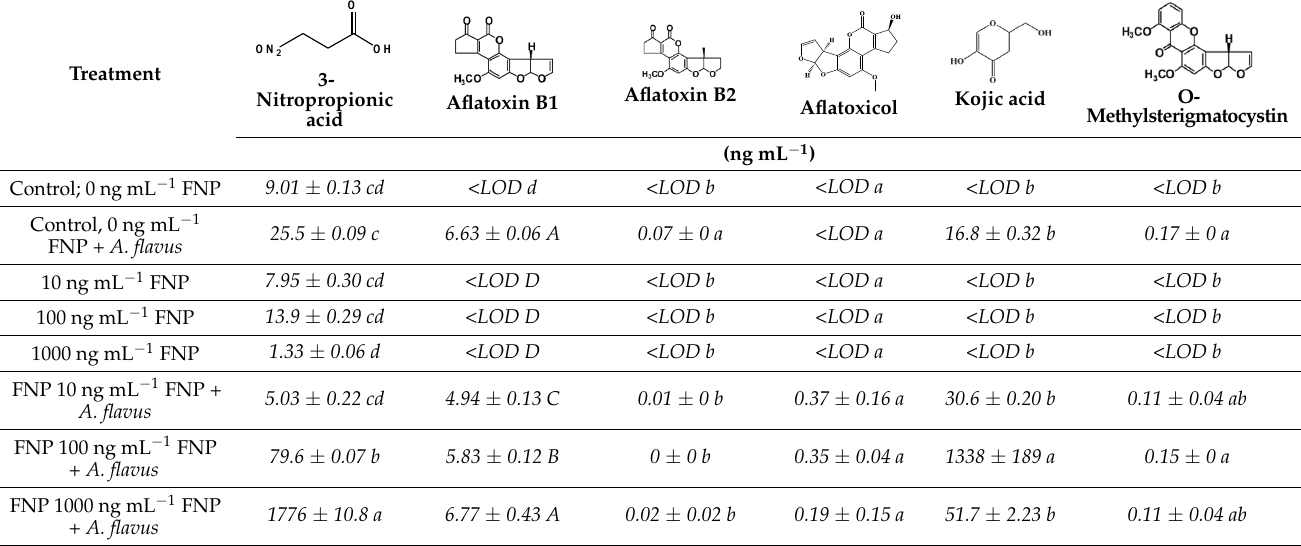
Values are represented as means ± SEM ( n = 3). The different letters in each column indicate statistically significant differences between treatments at p < 0.05, using Tukey’s post-hoc test. <LOD—below detection limit. The text following an equation need not be a new paragraph. Please punctuate